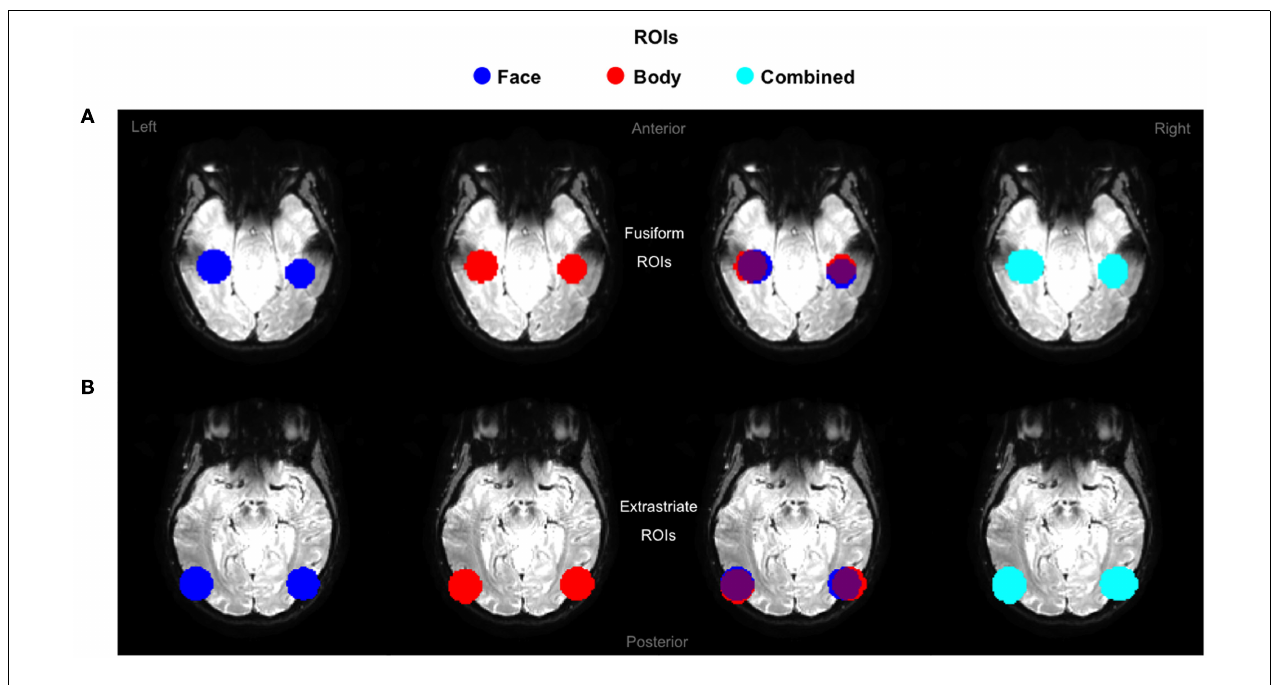
around the peak voxel of the FFA and FBA. (B) Extrastriate ROIs were defined with the exact same procedure around the peak voxels of the OFA and